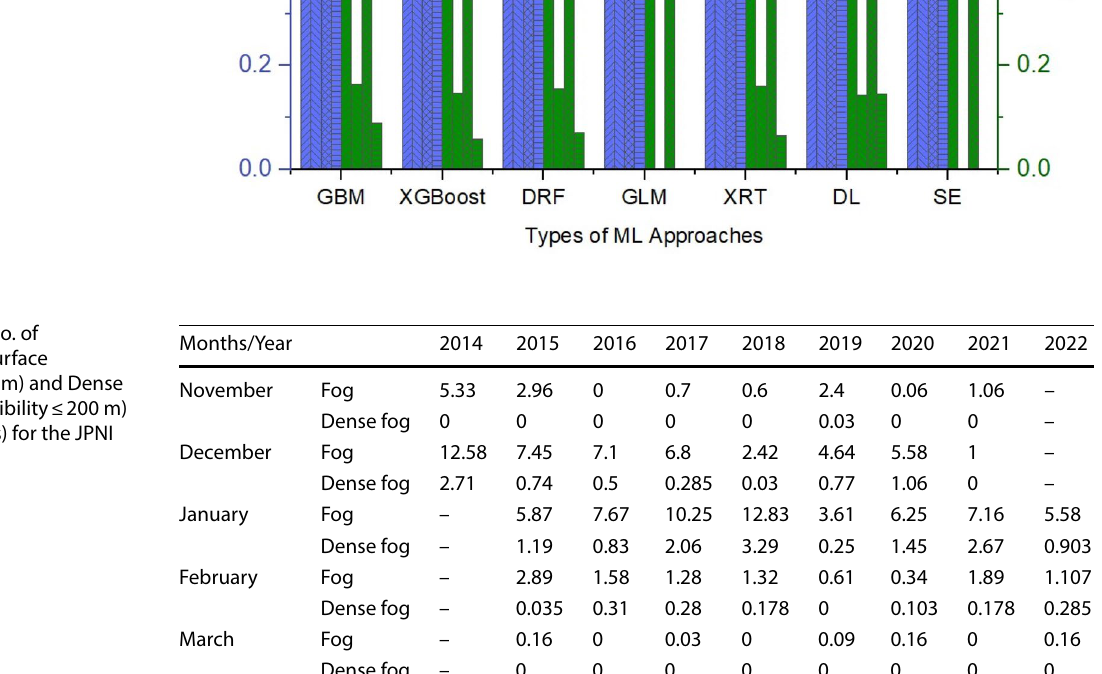
Fig. 6 Comparison of ML approaches performance for the prediction of fog (surface visibility ≤ 1000 m)for the lead time of 02 h (The blue color indicates the AUC and Ginni Index in the shown fig shows the AUC (Prediction of fog), shows AUC (pre- diction of dense fog),Similarly show shows ginni index for the prediction of fog, ginni index for the pre- diction of dense fog. Similarly green represents the MPCE and AUCPR for the prediction of fog as well as dense fog